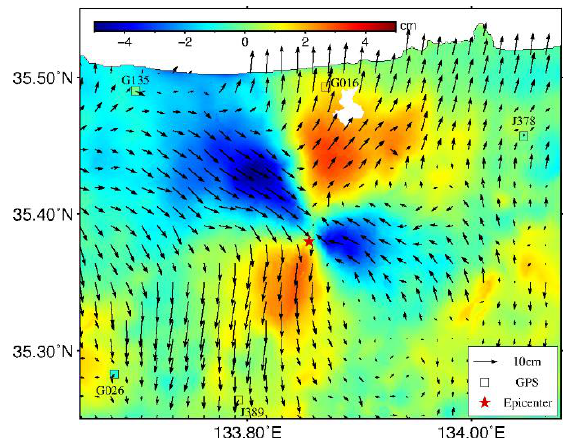
Figure 3. Three-dimensional deformations associated with the focal zone. The colored base map corresponds to vertical deformation and the arrows show the sub-sampled horizontal deformations. Rectangles show the location of GNSS